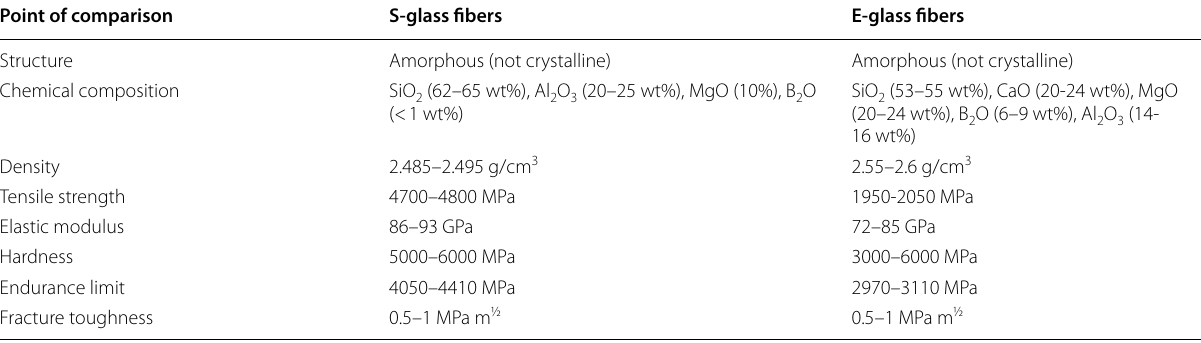
Table 1 A comparison between S‑glass and E‑glass fibers, composition and properties. (Meriç et al. 2005; Chong and Chai 2003; Vallittu 1998) Point of comparison S-glass fibers